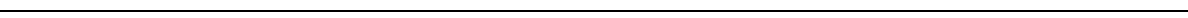
Fig. 6 Blunted hormone responsiveness in uterine stromal cells of aged females. a Venn diagram of de-regulated genes in deciduas of aged females and their proximity to oestrogen receptor- α (Esr1) and progesterone receptor (Pgr) binding elements. b E3.5 uteri stained for Pgr. White arrows point to the homogenous staining of Pgr in luminal epithelium (LE) of young uteri. Red-lined arrows highlight the mosaic staining of Pgr in LE of aged uteri with large patches exhibiting drastically reduced Pgr levels. Scale bar : 200 µ m. c E6.5 implantation sites developed in young and aged females stained for Pgr. Dotted lines demarcate the boundary between the primary (PDZ) and secondary (SDZ) decidualisation zones. In young females, decidualisation has progressed such that Pgr staining is strongest in the SDZ, whereas in aged females staining still highest in the PDZ. Red asterisks demarcate auto fl uorescence from blood cells. Scale bar : 500 µ m. d Proliferation curve of decidual stromal cells isolated from young and aged females either unstimulated or after exposure to the decidualisation-inducing cocktail estrogen (E2), progesterone (P4) and cAMP (mean ± S.E.M., n = 3). Two-way ANOVA with Holm-Sidak ’ s multiple comparisons test. e RT-qPCR analyses of decidualisation markers in uterine (decidual) stromal cells stimulated for 2 and 4 days (mean ± S.E.M., n = 3). * p < 0.05; ** p < 0.01 (pairwise one-tailed t -test). f Western blot for phosphorylated Stat3 (pStat3) in stimulated uterine stromal cells of young and aged females. Graph shows the pStat3/Stat3 ratio normalised to 2 day young cells (mean ± S.E.M., n = 6). * p < 0.05; ** p < 0.01 (ANOVA with Holm-Bonferroni ’ s post-hoc test). g pStat3 staining of E6.5 implantation sites. Insets show overview photographs of the implantation sites (Emb = embryo, MD = mesometrial decidua), the yellow rectangles demarcate the magni fi ed areas depicted. In young females, pStat3 staining is con fi ned to the nuclei of decidualised stromal cells, indicative of its functionally activated state including as co-activator of Pgr-responsive genes. In aged females, only very few decidual cells exhibit nuclear pStat3 staining ( white arrows ), whereas in the majority of decidual cells ( red-outlined arrows ) staining is distinctly excluded from the nucleus. Scale bars : 100 µ